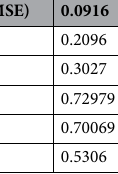
Table 9. Evaluation using SCG backpropagation.